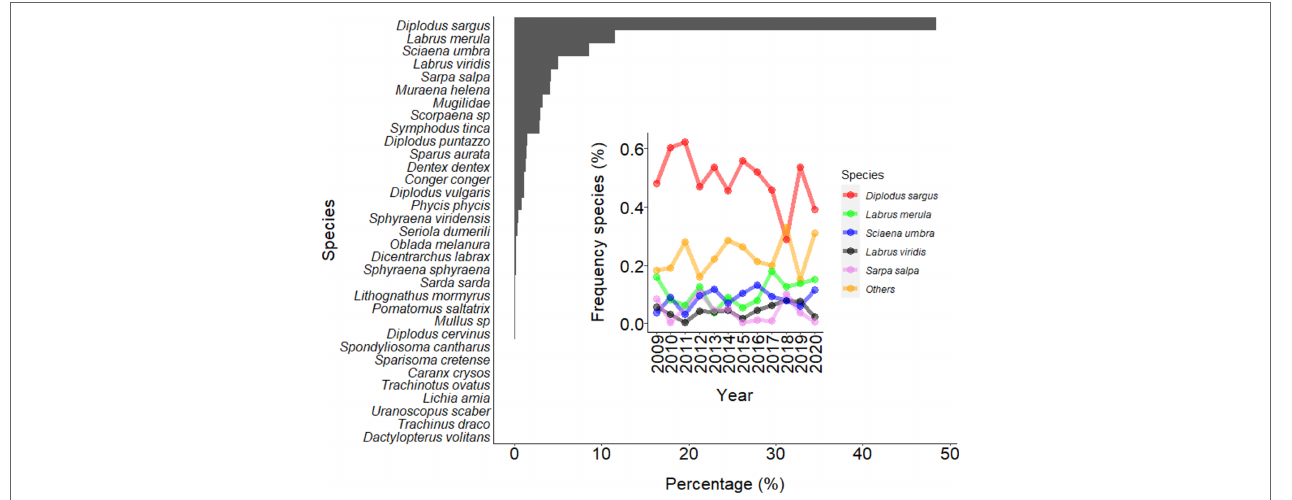
FIGURE 2 | The frequency and temporal changes of species caught by spearfishers during Italian marine spearfishing tournaments from 2009 to 2020 (N total = 8843; N D. sargus = 4286; N L. merula = 1018; N S. umbra = 759; N L. viridis = 443; N S. salpa = 368; N others =